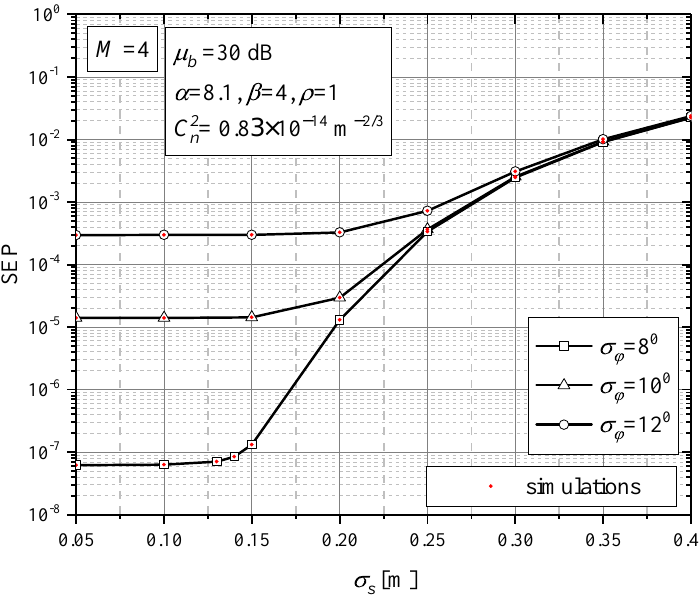
Figure 4. Average SEP vs. standard deviation of the pointing errors.